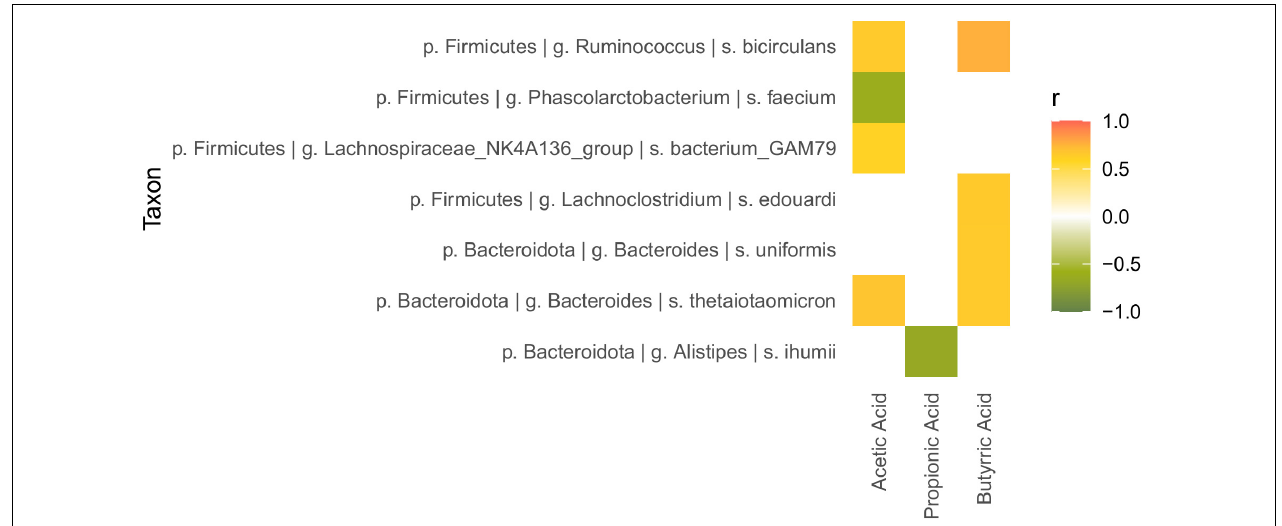
FIGURE 5 | Heatmap of the correlation between microbial relative abundance and SCFA production, calculated with the sPLS-based approach implemented in the mixOmics network function (correlation coefficient >